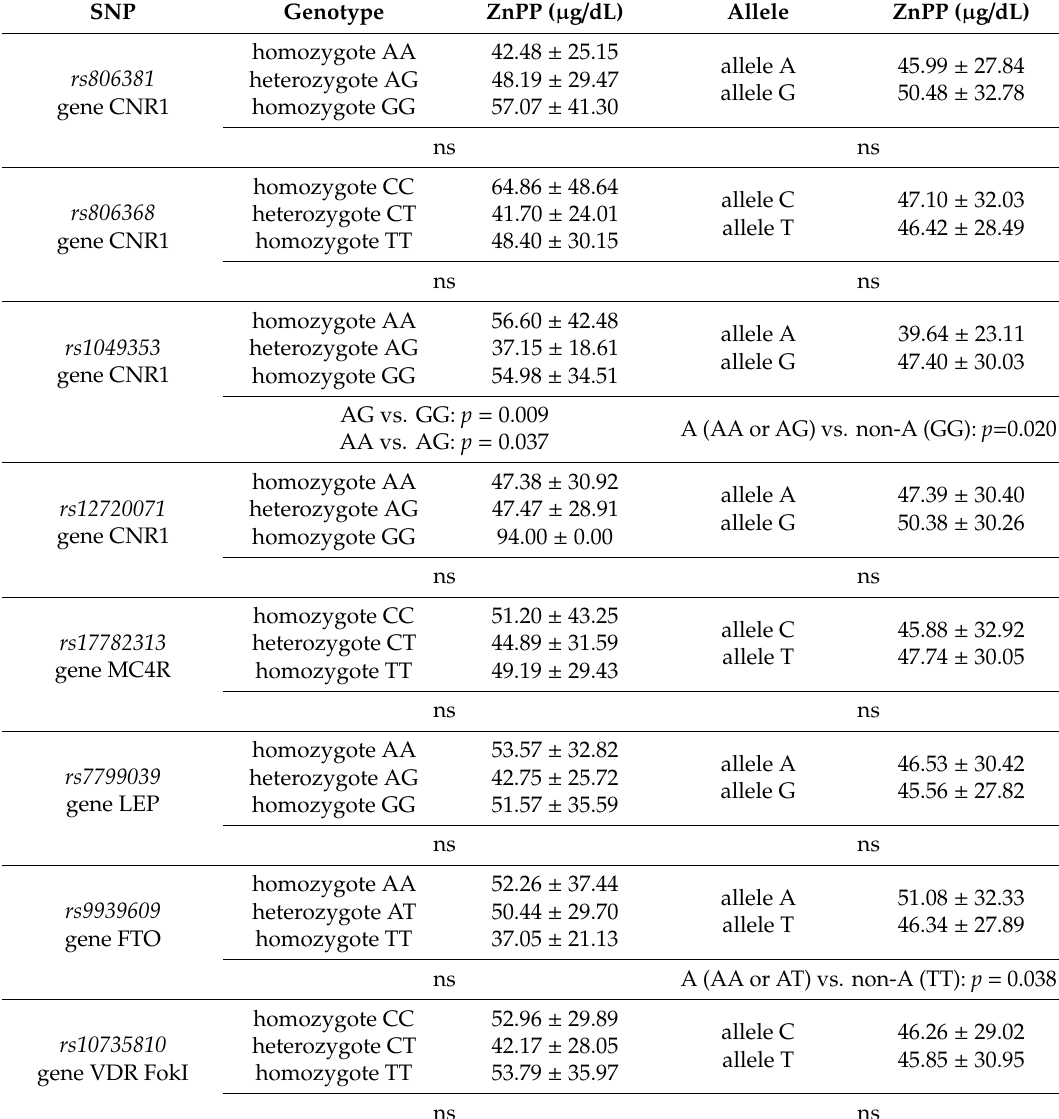
Table 8. Zinc protoporphyrins (ZnPP) concentration in subgroups divided according to selected polymorphisms of genes CNR1, MC4R, LEP, FTO and VDR